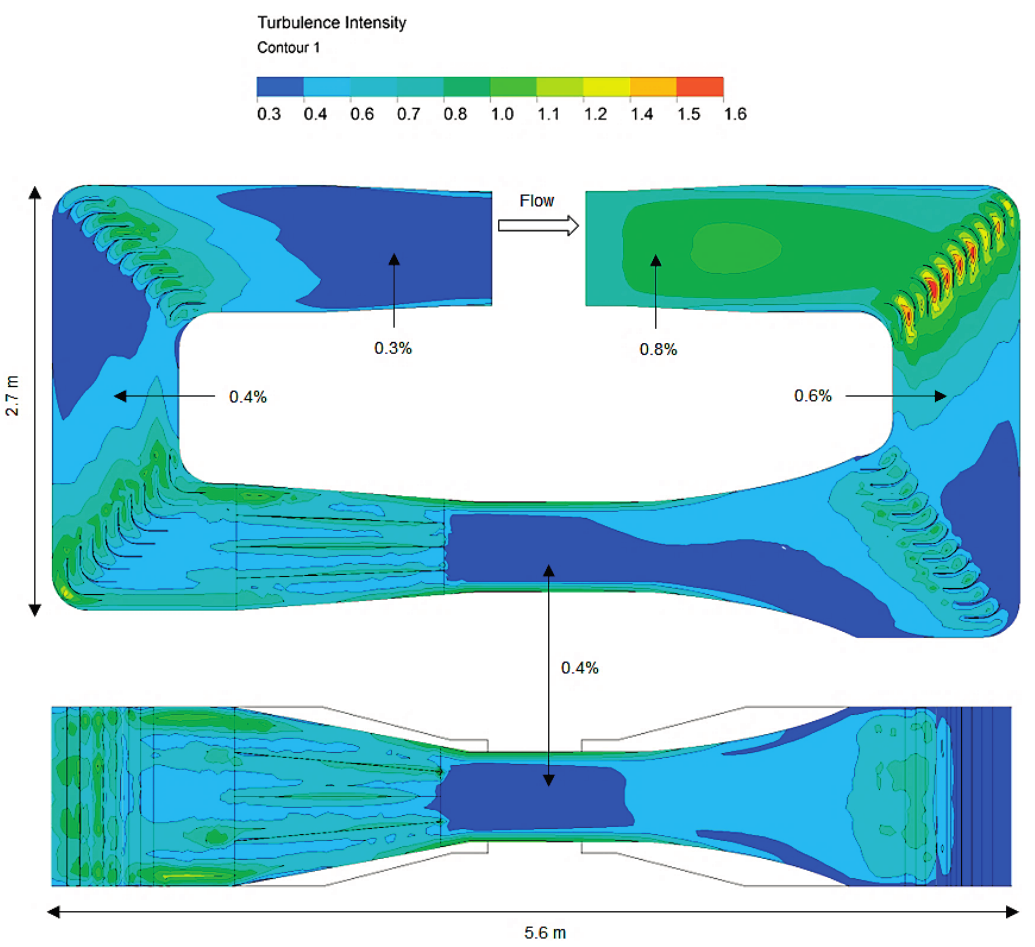
Figure 7. Turbulence intensity across the front plane of the wind